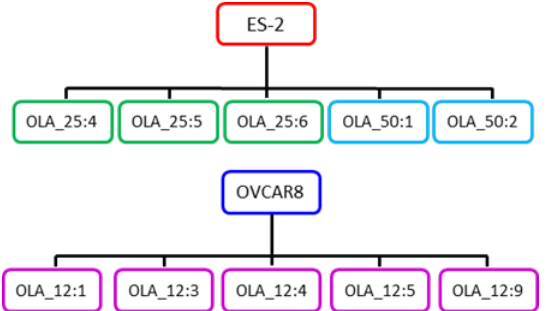
Figure 1. Olaparib-resistant high grade serous ovarian cancer (HGSOC) clones. Independent clones resistant to olaparib were first isolated from the homologous recombination repair (HRR)-proficient ES-2 cell line. Clones shown in green and blue boxes were isolated after parental cells were challenged with 25 and 50 µM olaparib, respectively. Olaparib-resistant clones were also isolated from the HRR-deficient OVCAR8 cell line. Clones shown in pink boxes were isolated after parental cells were treated with 12 µM olaparib. All the resistant clones were isolated in a single selection step from their ES-2, or OVCAR8 parent. Only clones used for subsequent analysis are shown here.